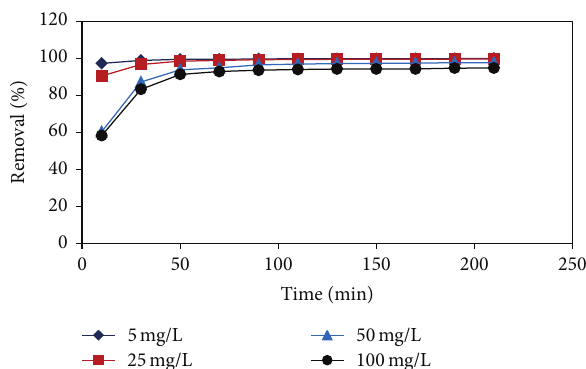
Figure 1: Effect of MKCF dosage on RO16 removal.